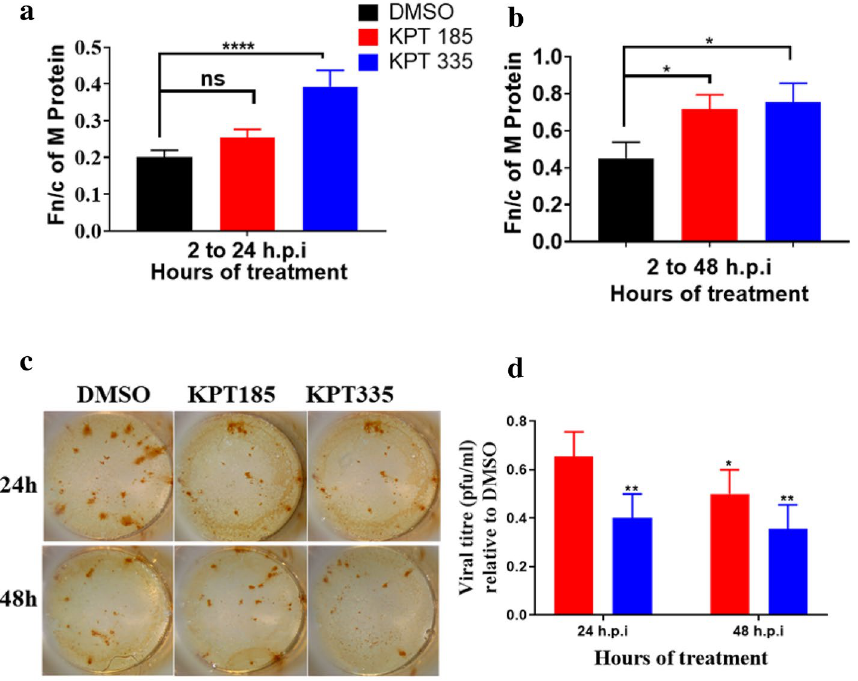
Figure 5. Therapeutic treatment with SINE compounds reduces RSV replication and disrupts export of M protein. A549 cells were infected at MOI = 1 for 1 h and treated from 2 h.p.i onwards with 1.5 μM of KPT-185 or KPT-335 or DMSO (control). The cell lysates were collected, or cells were fixed at 24 and 48 h.p.i. and analysed using immunofluorescence and immunoplaque assays. Nuclear localization of M protein in cells treated up to ( a ) 24 h.p.i and ( b ) 48 h.p.i. was determined as in Fig. 4. Data shown are mean ± SEM from three independent experiments. ( c ) Representative images of plaques formed from cell lysates collected from infected cells treated up to 24 and 48 h.p.i. ( d ) Viral titre relative to DMSO-treated cell lysates after treatment with SINE compounds. Data shown are mean ± SEM from quadruplicate samples from three independent experiments. Statistical